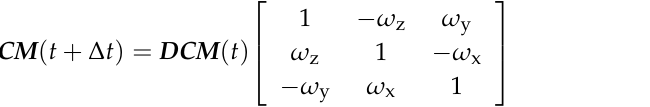
Figure 2. Connection of the sensor coordinate system with the ground reference system in the horizontal plane